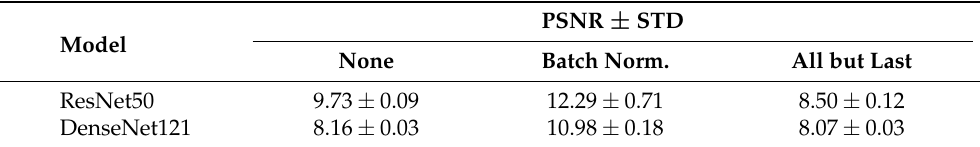
Table 4. Impact of layer freezing on the attack success during early training. We report the mean PSNR and sample standard deviation (STD) over all images obtained from three attack trials per setting. The batch size is kept constant at one. The attack was only successful on models with frozen batch normalization